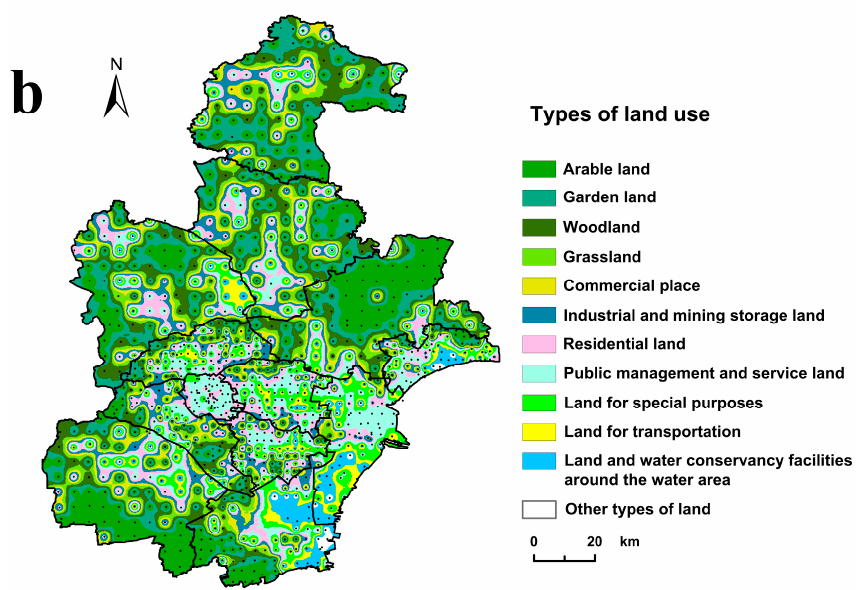
Figure 1. Sampling map of soil samples in Tianjin in this study. ( a ) Map of soil sampling location; ( b ) Distribution map of land use types at sampling points.